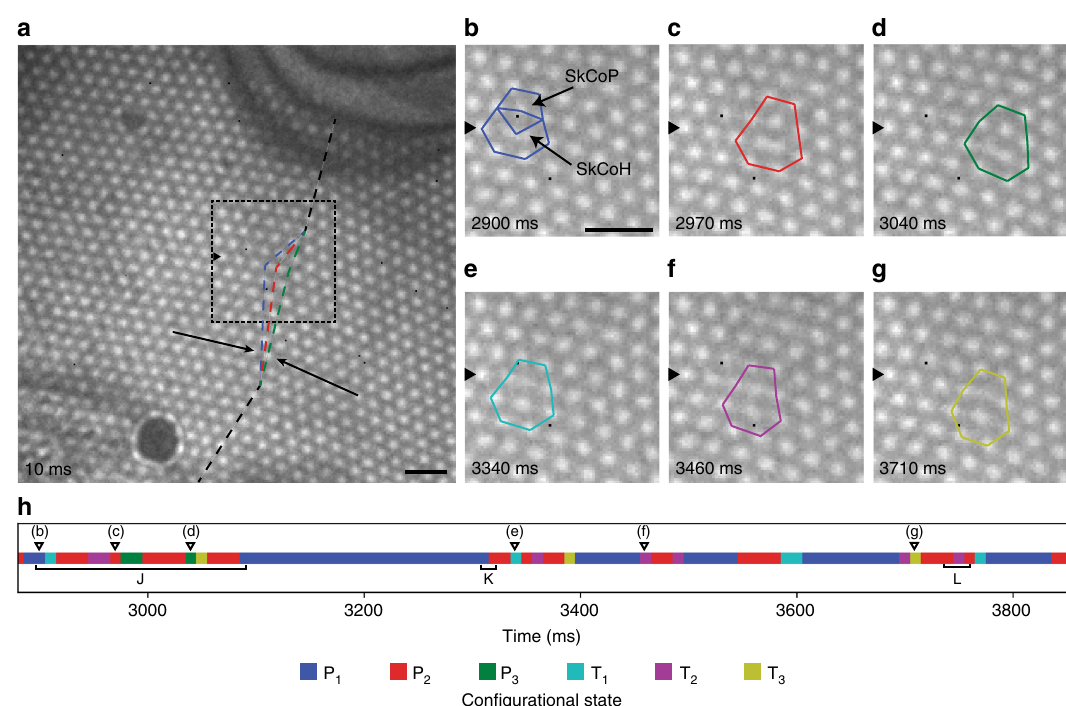
Fig. 1 Fresnel TEM images of SkX and identi fi cation of con fi gurational states. a Entire region of observed skyrmion lattice, showing the domain boundary with an average misorientation angle of 14° (black dashed line) and principle lattice vectors (arrows). The three coloured (blue, red and green) dashed lines demonstrate how the domain boundary shifts during transitions between the P x states and the associated lateral skyrmion motion. Scale bar, 200 nm. b – g Examples of the six con fi gurational states observed, with the time of each frame given in the bottom left corner of each image. The black arrowheads point along the row of skyrmions, in which lateral motion was taking place (same position in each image). Skyrmions with seven- and fi vefold coordination (SkCoH and SkCoP, respectively) are highlighted by the conjoined pentagons and heptagons. Scale bar, 200 nm. h A portion of the transition data showing the progression of reversible transitions between states shown in b – g . The markers ( b – g ) additionally indicate the time of occurrence of the images shown in b – g . Colour in each panel is associated with the identi fi ed con fi gurational states, according to the bottom